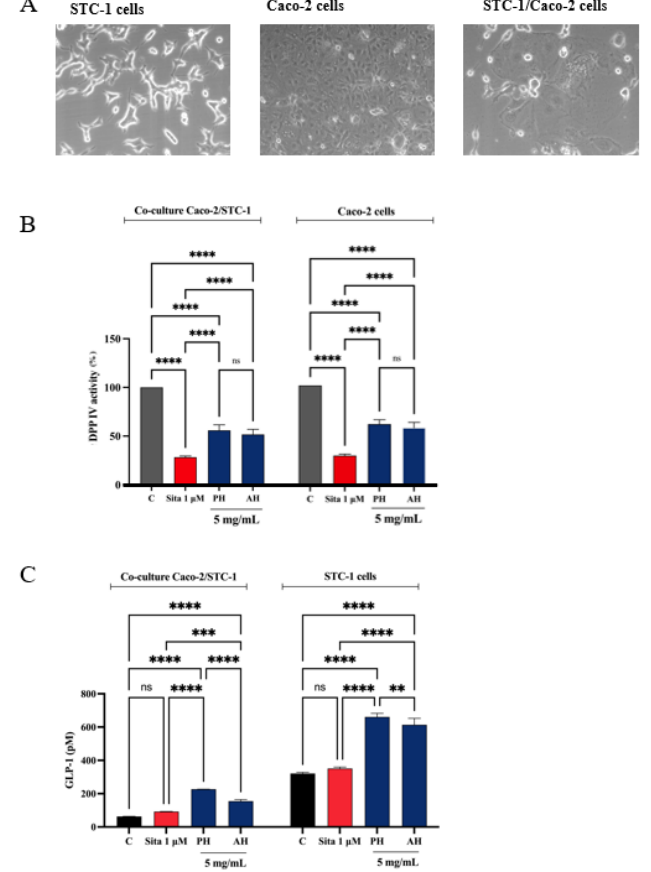
Figure 13. ( A ) Microscope cell images obtained by AxioCam MRc 5 Zeiss after 48 h from seeding. ( B ) Effect of PH and AH on the in situ DPP-IV activity in both co-culture Caco-2/STC-1 and Caco-2 alone cells, respectively. ( C ) Effect of PH and AH on the GLP-1 concentration levels (expressed as pM) in both co-culture Caco-2/STC-1 and STC1-alone cells, respectively. Data points represent averages ± s.d. of three independent experiments in duplicate. All data sets were analyzed by two-way ANOVA followed by Tukey’s post hoc test. C, control sample; Sita, sitagliptin; ns, not significant. (**) p < 0.01, (***) p < 0.001, and (****) p < 0.0001 vs. control (C).